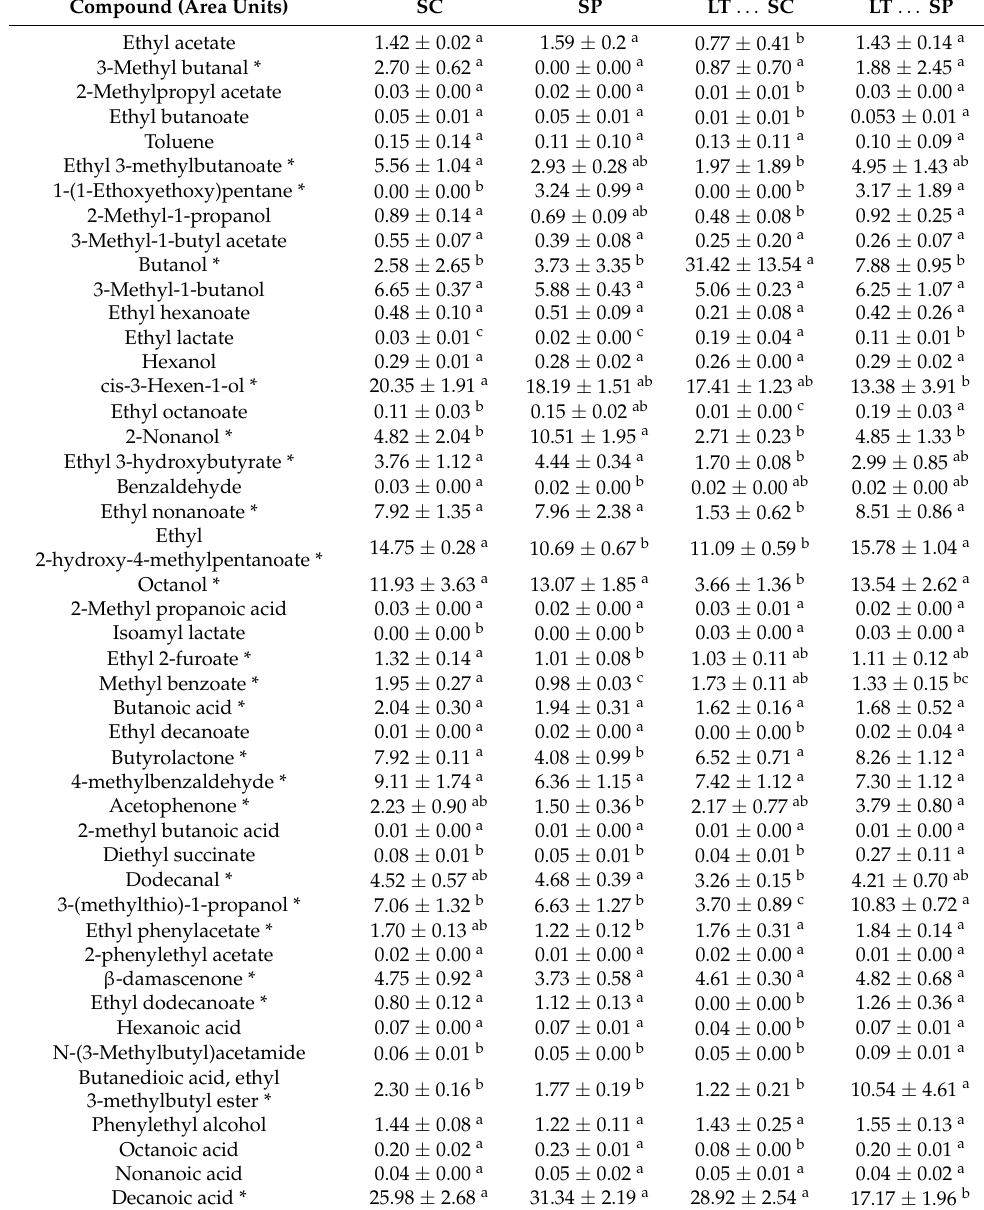
Table 3. Final volatile compound profiles of fermentations from Tempranillo red